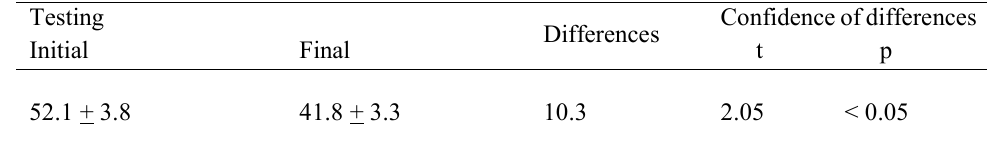
Table 1. Quantity of diseases (M+m, %) Testing